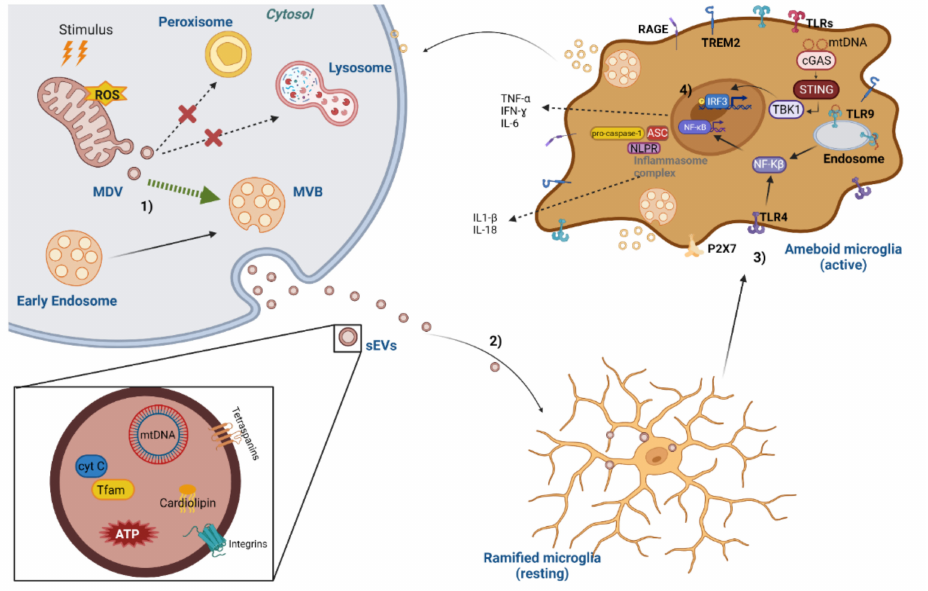
Figure 2. Molecular mechanisms of EV-associated DAMPs-mediated neuroinflammation. (1) Af- ter an oxidative stimulus, increased levels of reactive oxygen species (ROS) lead to generation of mitochondrial-derived vesicles (MDVs). The process of MDV production can result in delivering oxidised proteins to peroxisome/lysosome degradation or routing them to the multivesicular bodies (MVBs), which will be released as extracellular vesicles (EVs). Several mitochondrial components can be released within MDVs, including mtDNA, cardiolipin, cytochrome C, mitochondrial tran- scription factor A (TFAM) and N-formyl peptides, which are considered as mitochondrial damage- associated molecular patterns (DAMPs). (2) Mitochondrial DAMPs in EVs can initiate a microglia pro-inflammatory immune response by inducing a conformational change from a normal